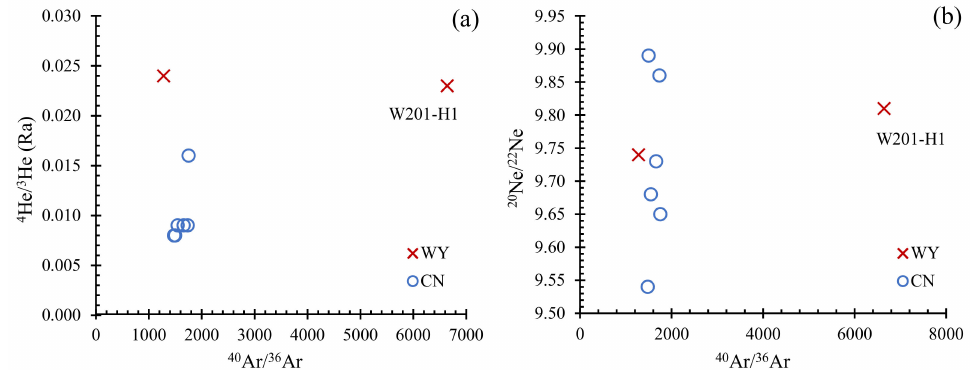
Figure 6. Plots of ( a ) 3 He / 4 He vs. 40 Ar / 36 Ar and ( b ) 20 Ne / 22 Ne vs. 40 Ar / 36 Ar of Longmaxi shale gases in the Weiyuan (WY) and Changning (CN) areas,